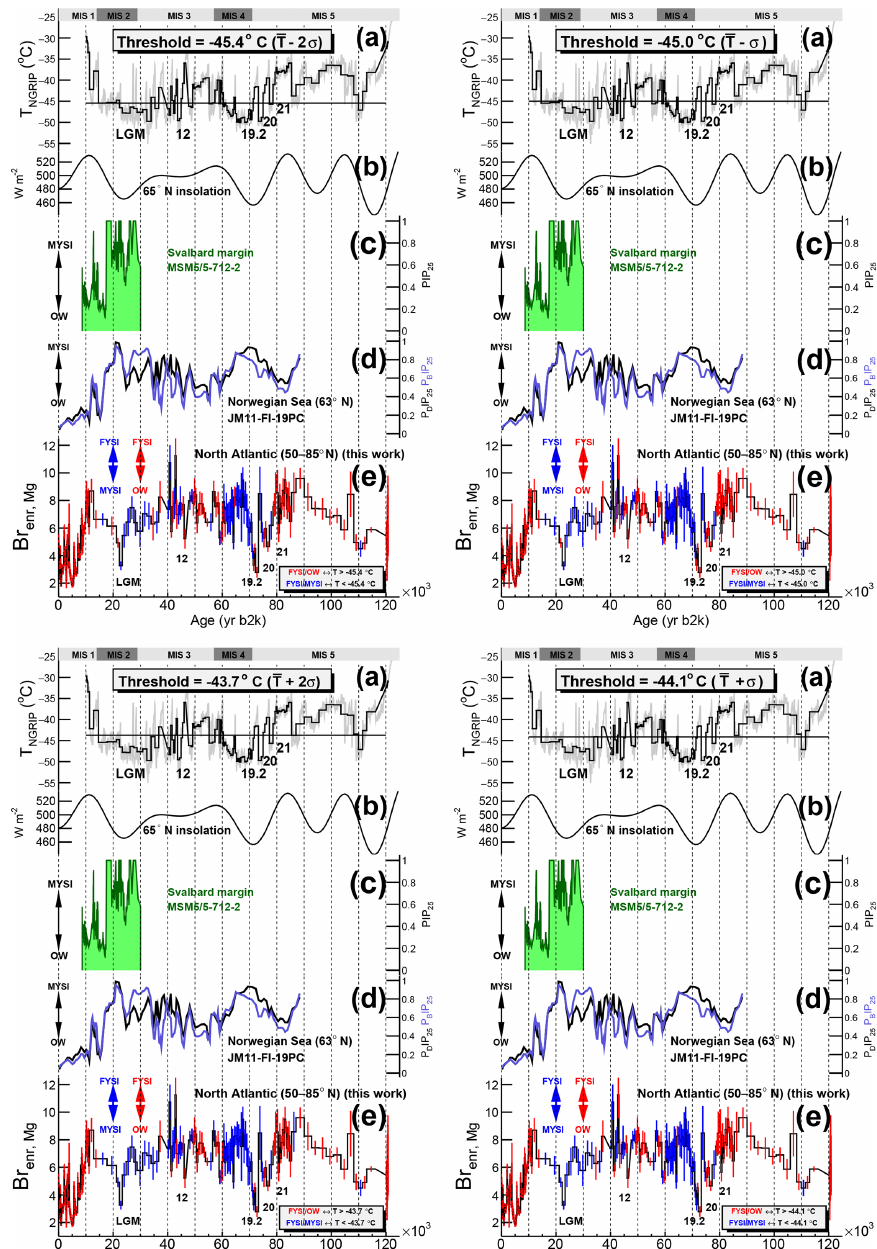
Figure D1. Sensitivity test of the NGRIP temperature threshold used to perform the Br enr , Mg regime discrimination (see Fig. D2 for the equivalent analysis using Br enr , Cl ). (a) Reconstructed NGRIP temperature (grey, Kindler et al., 2014). The temperature threshold value is the mean temperature ( T ± 2 σ : left; T ± 1 σ : right) during the 11.8–12.4ka period, when the change in Br enr , Mg regime was observed (see Fig. 6). The black time series is the temperature profile downscaled to the measured Br enr resolution. The numbers indicate the Greenland Intersta- dials (GIs) discussed in the text; (b) 21 June daily mean insolation at 65 ◦ N (Laskar et al., 2004); (c) PIP 25 record from the Svalbard margin (core MSM5/5-712-2 from Müller and Stein, 2014); (d) 90kyr P D IP 25 and P B IP 25 records from the Norwegian Sea presented as five-point running mean (from Hoff et al., 2016); (e) discrimination between the Br enr , Mg regimes computed according to the integrated temperature value with respect to the threshold. The FYSI/OW and FYSI/MYSI regimes are indicated with red and blue error bars